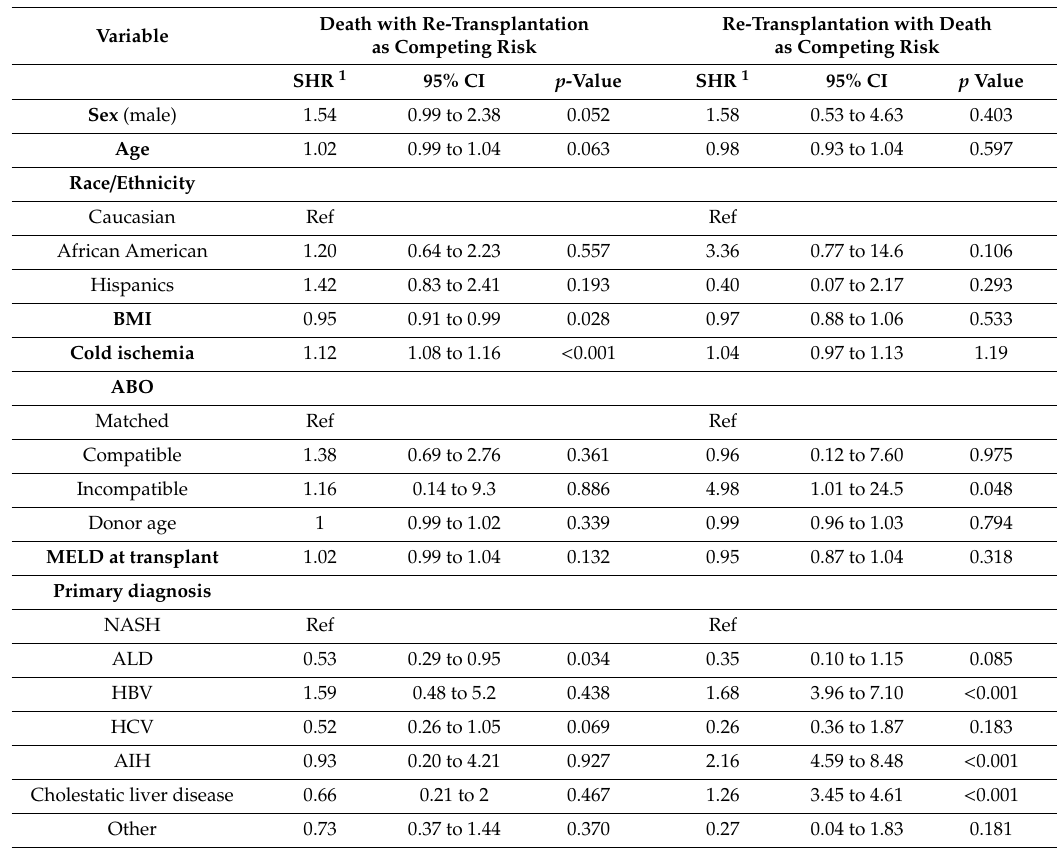
Table 3. Competing risk analysis.